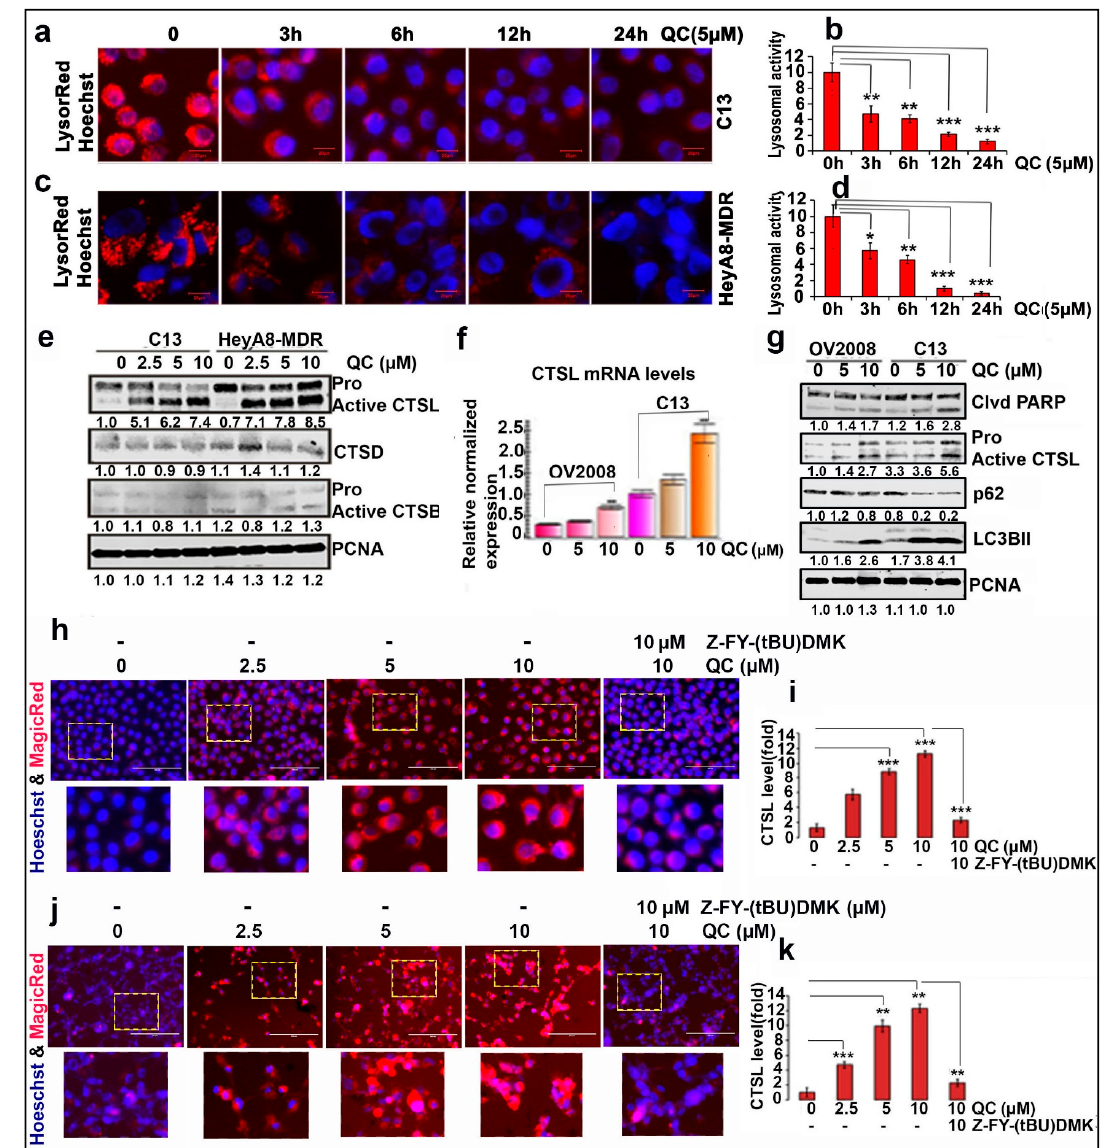
Figure 1. QC induces LMP by upregulating CTSL and its activity. C13 and HeyA8-MDR cells were exposed to QC at 5 µM concentration for 3, 6, 12, 24 h and labeled with LysoTracker red and Hoechst 33342, and LMP induction was assessed. Representative images of time-dependent effect of QC on LMP induction in ( a ) C13 cells and ( b ) HeyA8-MDR cells are presented. Graphical representation of QC-induced lysosomal disruption by quantifying the loss of red signal is provided for both ( c ) C13 and ( d ) HeyA8-MDR cells; ( e ) C13 and HeyA8-MDR cells were exposed to QC at 0, 2.5, 5, 10 µM concentrations for 24 h and Western analysis was performed for CTSL, CTSB and CTSD expression. ( f ) Expression of CTSL was analyzed by q-PCR upon treatment of OV2008 and C13 cells with 5 and 10 µM QC for 24 h. ( g ) Western analysis of CTSL was performed under similar treatment condition and sensitization of the cells to QC treatment was estimated by Western analysis of cleaved PARP, LC3BII and p62/SQSTM1. Magic Red assay to measure CTSL activity upon QC treatment was performed in a dose-dependent manner with or without CTSL inhibitor Z-FY (tBU)-DMK in ( h ) C13 and ( j ) HeyA8-MDR cells (Scale bar 100µm and 40× magnification). ( i ) and ( k ) Fold change was calculated and plotted. Significance was expressed as * p < 0.05, ** p < 0.01, *** p < 0.001. Abbreviations: CTSL: Cathepsin-L; CTSB: Cathepsin-B; CTSD: Cathepsin-D; LC3B: Light Chain 3B; PCNA: Proliferating cell nuclear antigen.